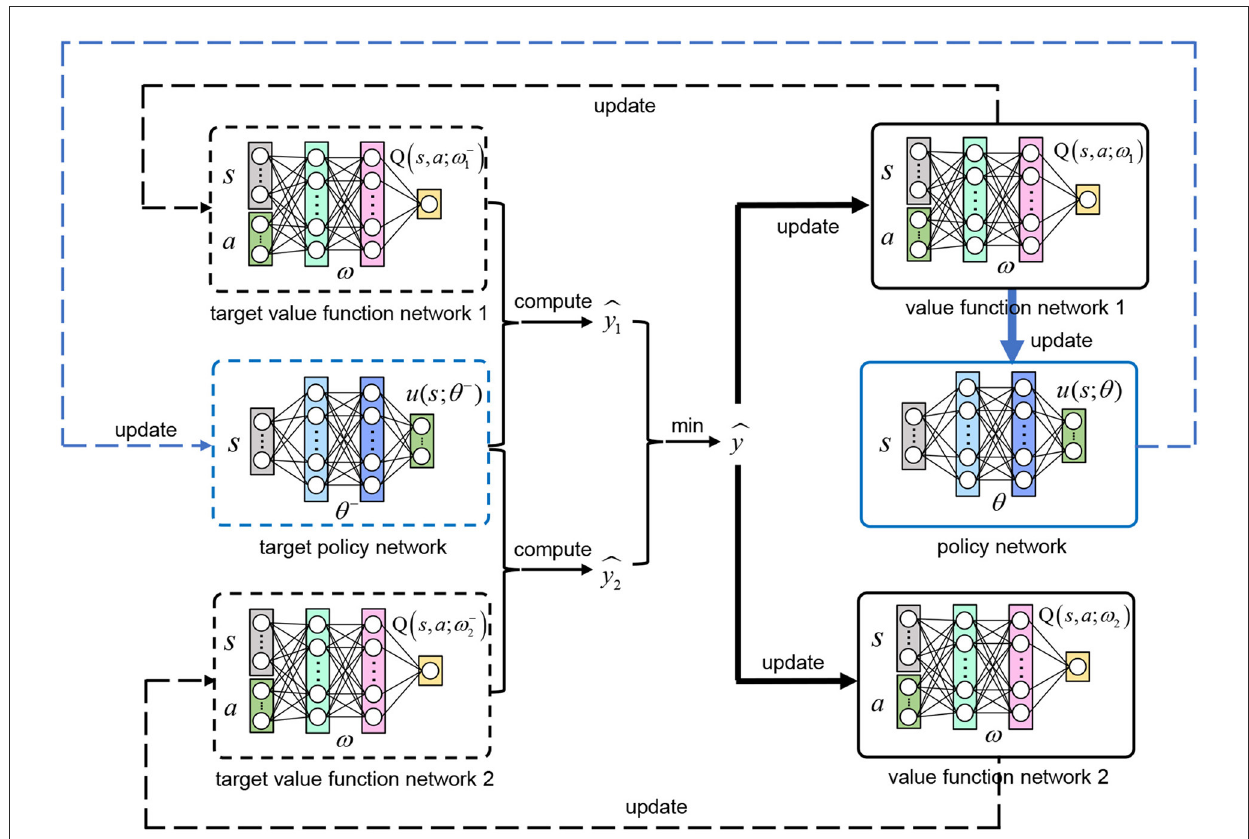
FIGURE3 The relationship between the six networks. The TD target ˆ y is estimated with the target value function network 1 and 2 using our clipped double Q-learning and bias correction based algorithm (Equation 12), which is used to update the value function network 1 and 2. With the gradient of Q ( s t , a t ; ω 1 ) to a , the policy network is updated with Equation (13). Three target networks ( u ( s t ; θ − ), Q ( s t , a t ; ω − 1 ), Q ( s t , a t ; ω − 2 )) adopt soft updates according to their corresponding evaluation networks ( u ( s t ; θ ), Q ( s t , a t ; ω 1 ), Q ( s t , a t ; ω 2